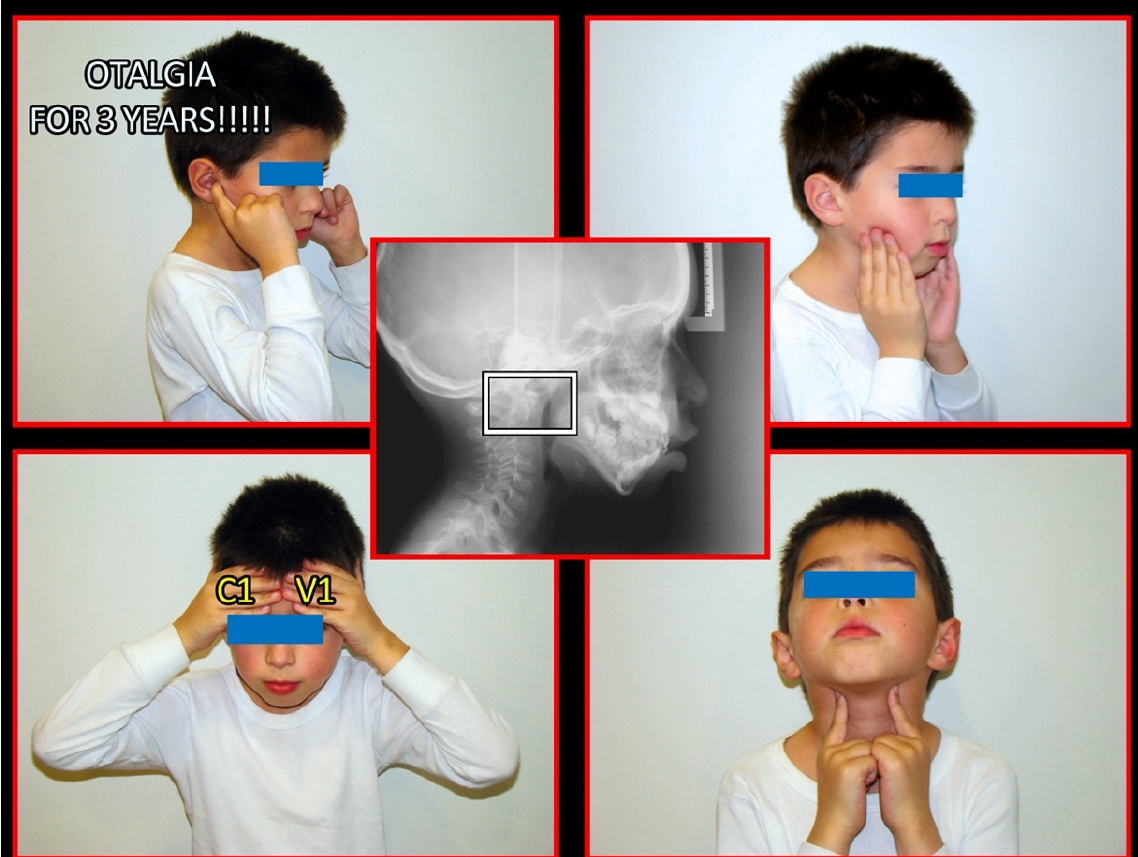
Figure 6. Pediatric patient with otalgia, headache, and pain of the occiput. Source: Rocabado Institute, Chile. Atlas - axis syndrome previously not diagnosed. The importance of the neurological connection between the cervical spine and the craniofacial and craniomandibular system. Patient showing sites of pain.